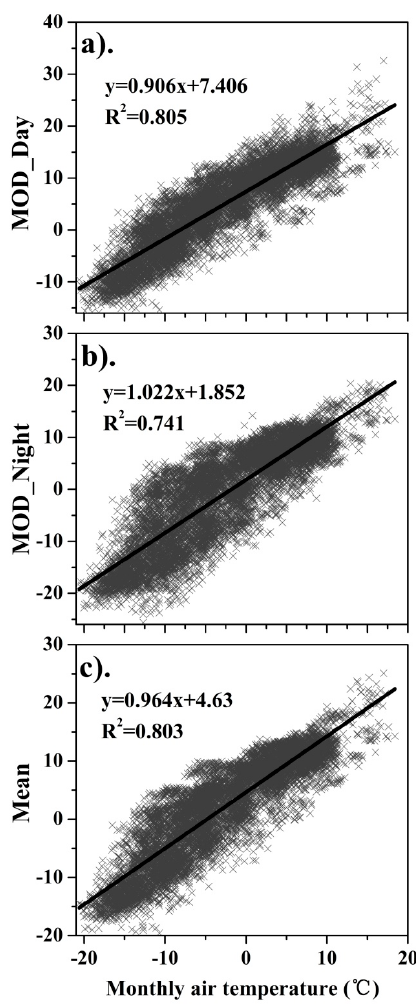
Figure 10. The relationships between monthly air temperature over lakes and averaged monthly lake surface temperature (WST) derived from MODIS images from 2001 to 2015: ( a ) daytime; ( b ) nighttime; and ( c ) mean WST of daytime and nighttime values.